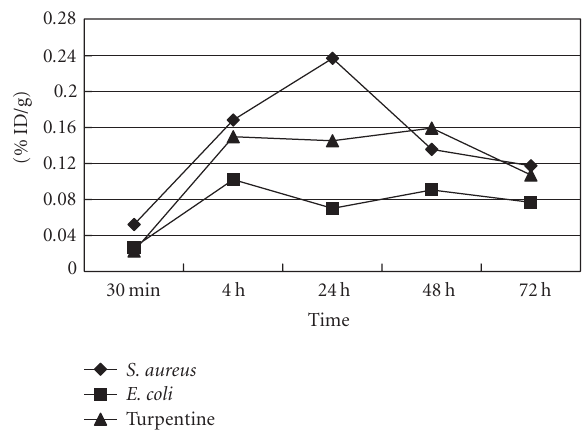
Figure 2: Accumulation of 125 I-anti-MIF McAb in the inflamma- tory tissue of S. aureus group, E. coli group, and turpentine oil group (% ID/g, x ±